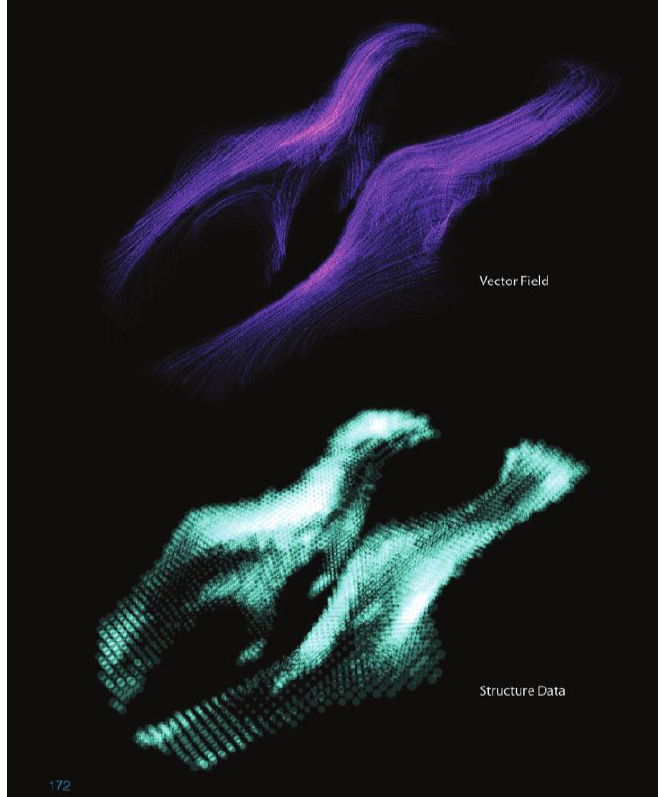
Figure 14. The navigation system can - to a certain extend - re-organize the organizational logic which might be initially implied. Architecture's ability to transmit and screen information has led to an exponential development of technologies that will take study of space as shape and matter back to the origins of life while advancing a future based on ever faster evolutionary processes. The emergence of new sciences based on the nature of information, such as genomics, biochemistry and computational biology, has accelerated our evolution and adaptation. This acceleration results from the increasing specialisation of technological tools, an excellent economy of death and time. In other terms: of architecture evolution and adaptation